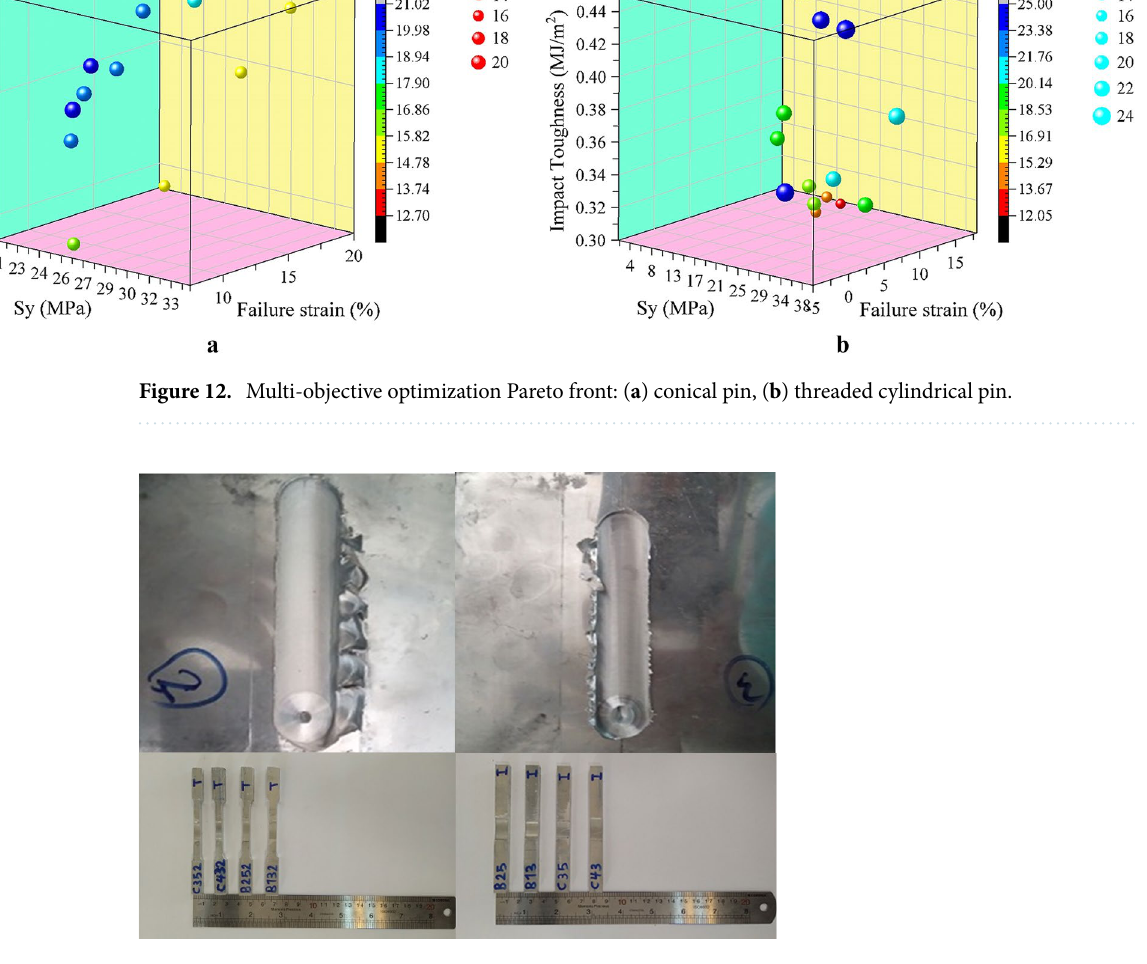
Figure 13. The welded specimens with the optimized welding